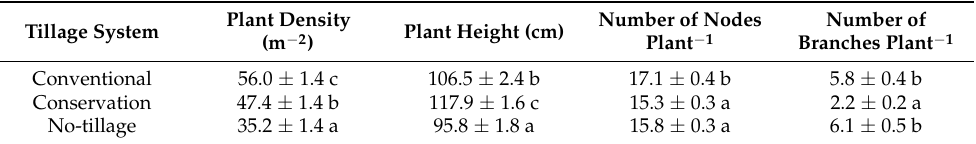
Table 1. Growth parameters for the soybean plants according to the different tillage systems. Tillage System